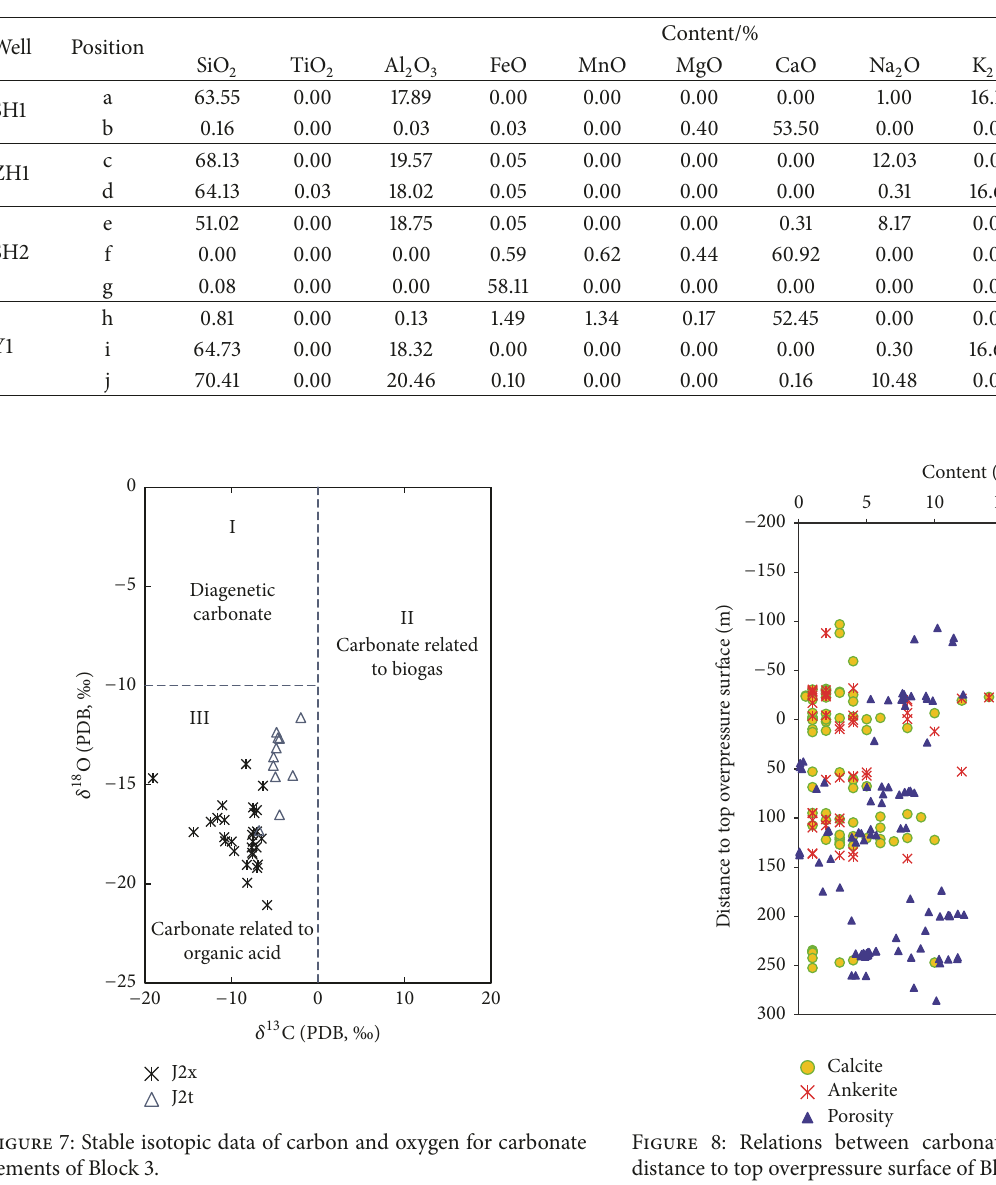
Table 4: Electron microprobe analysis of residual mineral contents in secondary pores of wells in studied area.